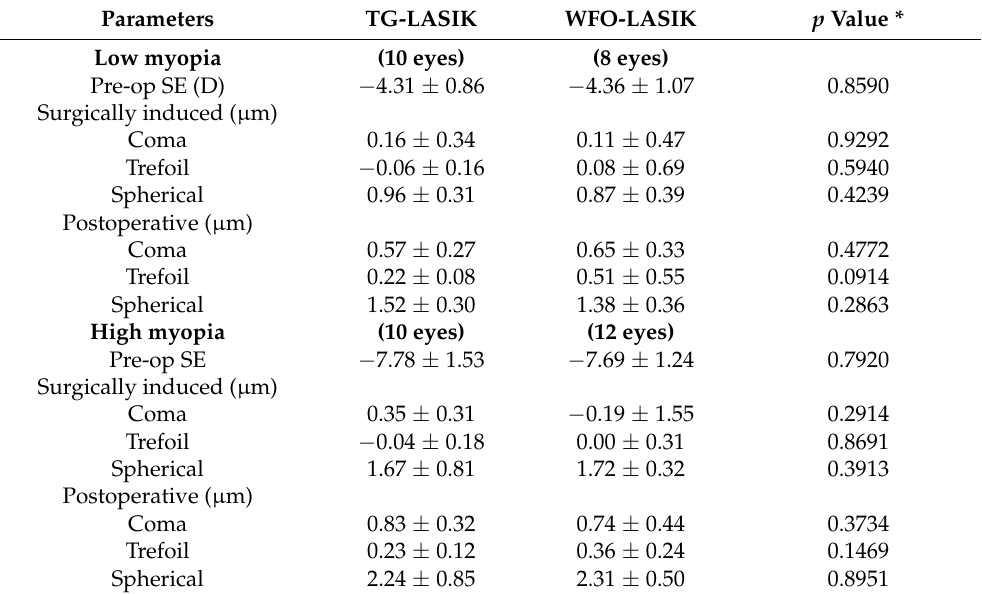
Table 5. Comparison of clinical characteristics between high- and low-myopia groups by TG and WFO ablation after 3